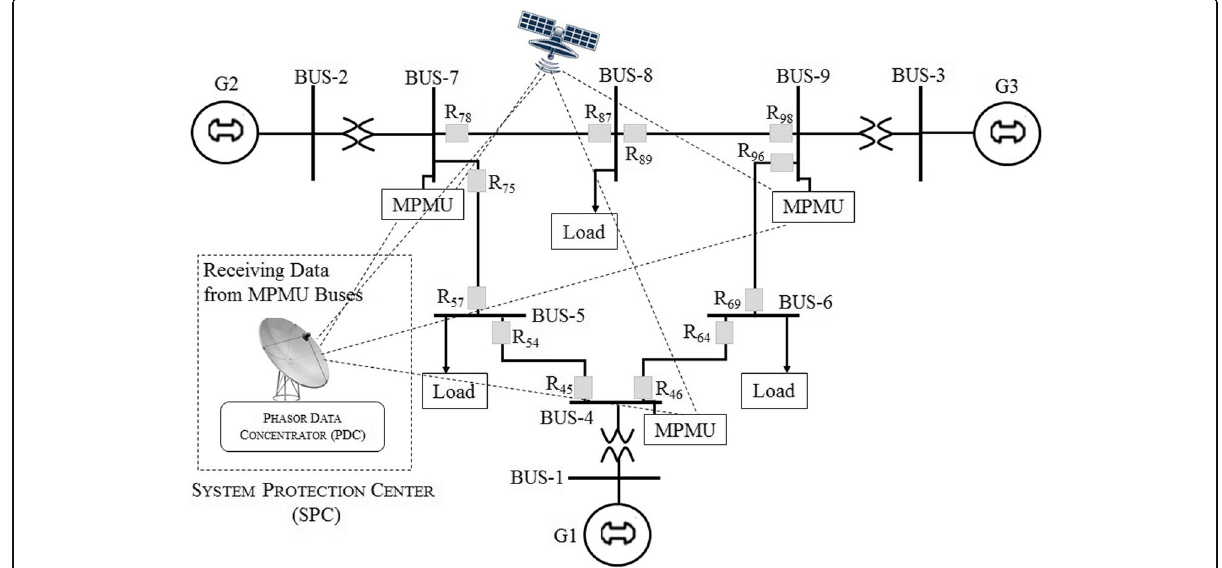
Fig. 2 Single line diagram of Western State Coordinate Council − 9 (WSCC-9) bus